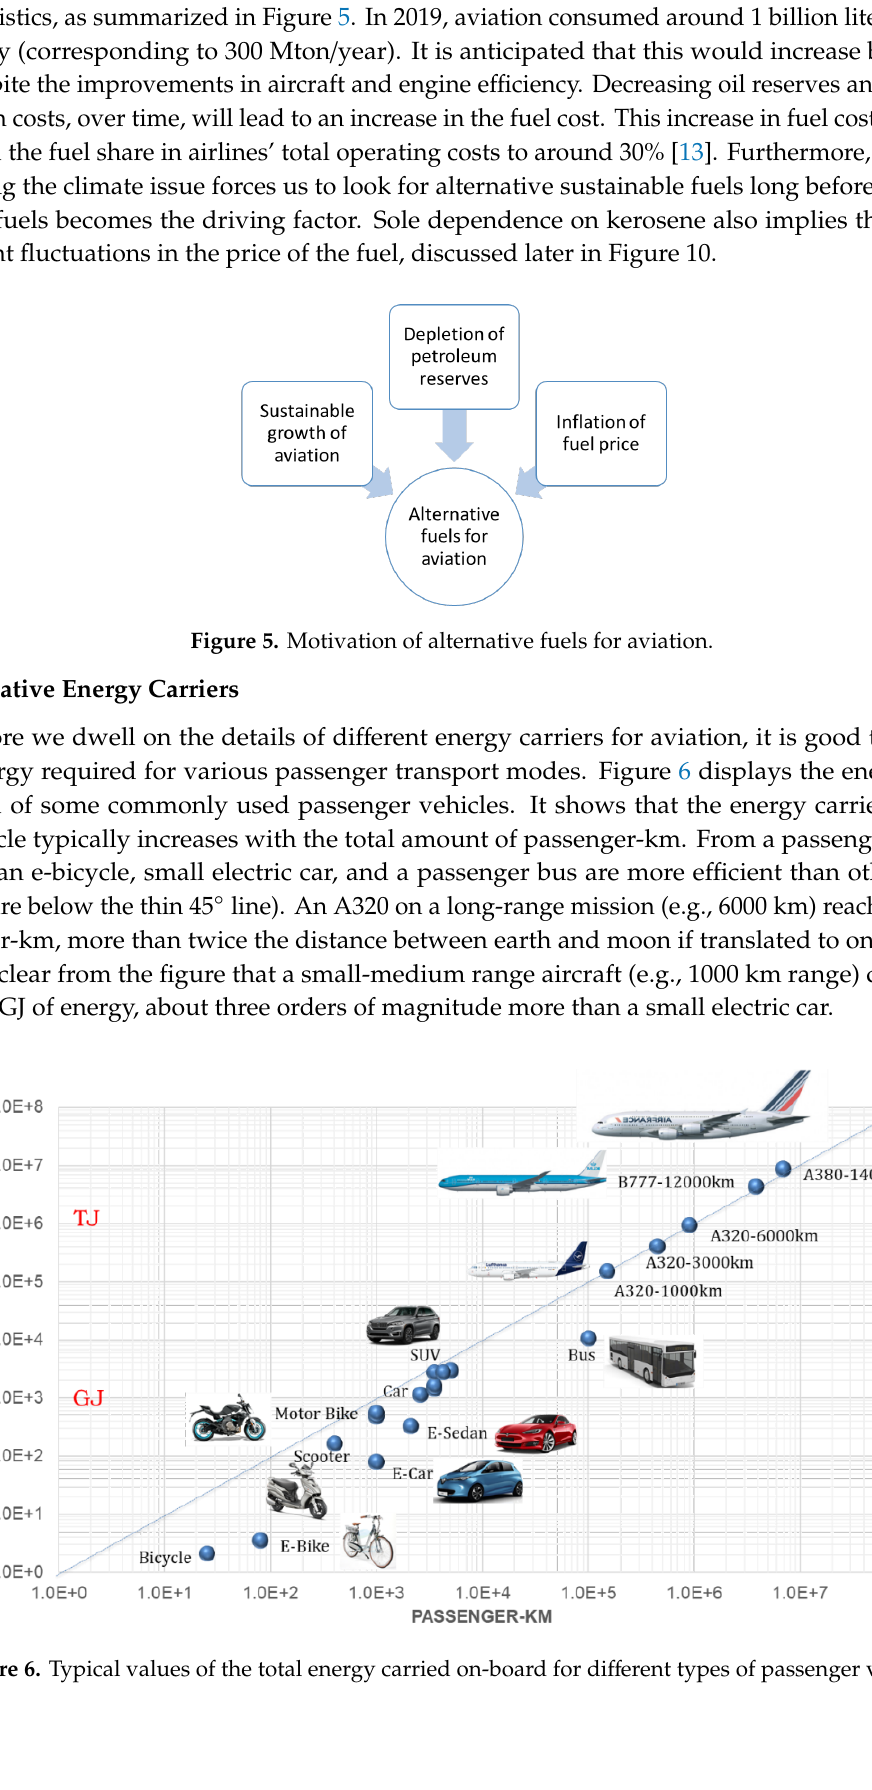
Figure 4. Increase in global revenue passengers-km (RPK) and fuel consumption for civil aviation (sources: Statistica, International Civil Aviation Organization (ICAO), IATA).